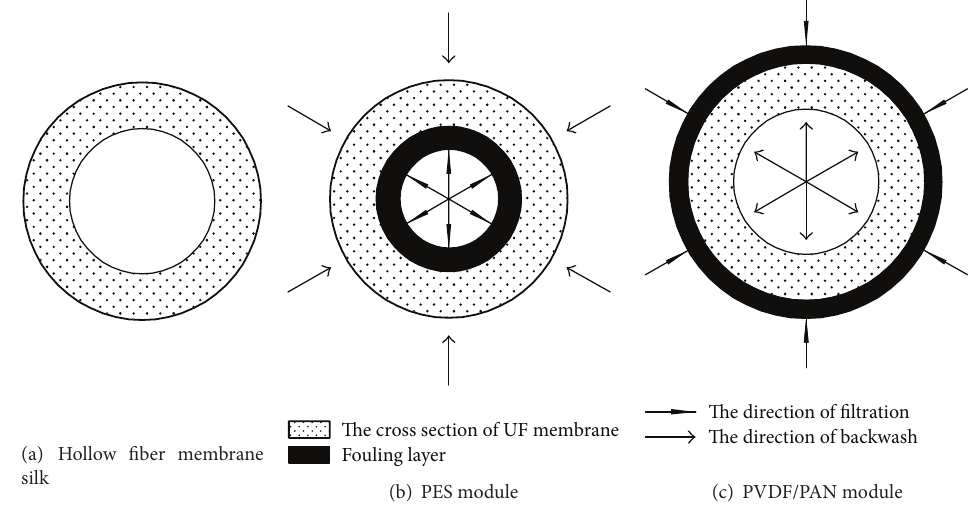
Figure 7: Flow channel of various UF